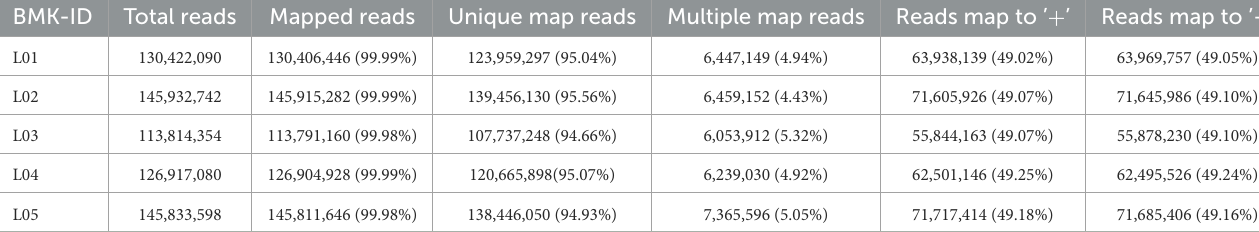
TABLE 4 Statistics of comparison results between clean data and reference genome.